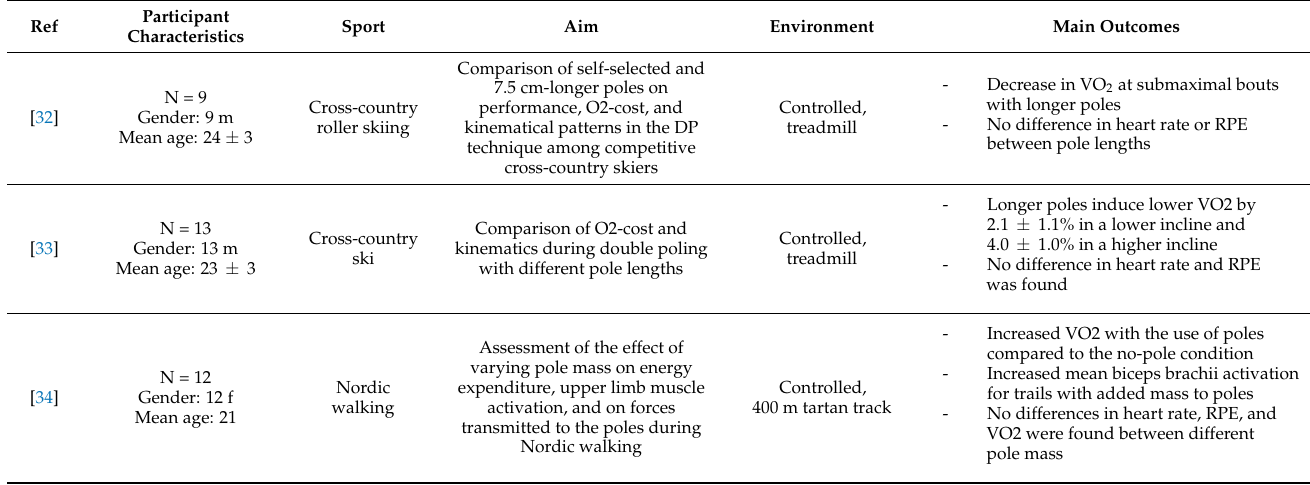
Table 4. Pole property aspects of pole